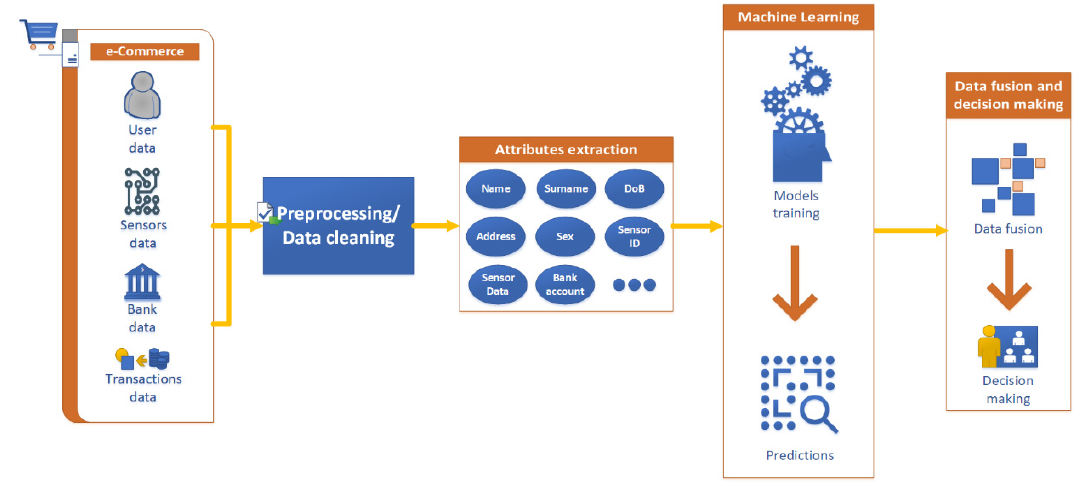
Figure 1. Process flow for data fusion in an e-commerce system.